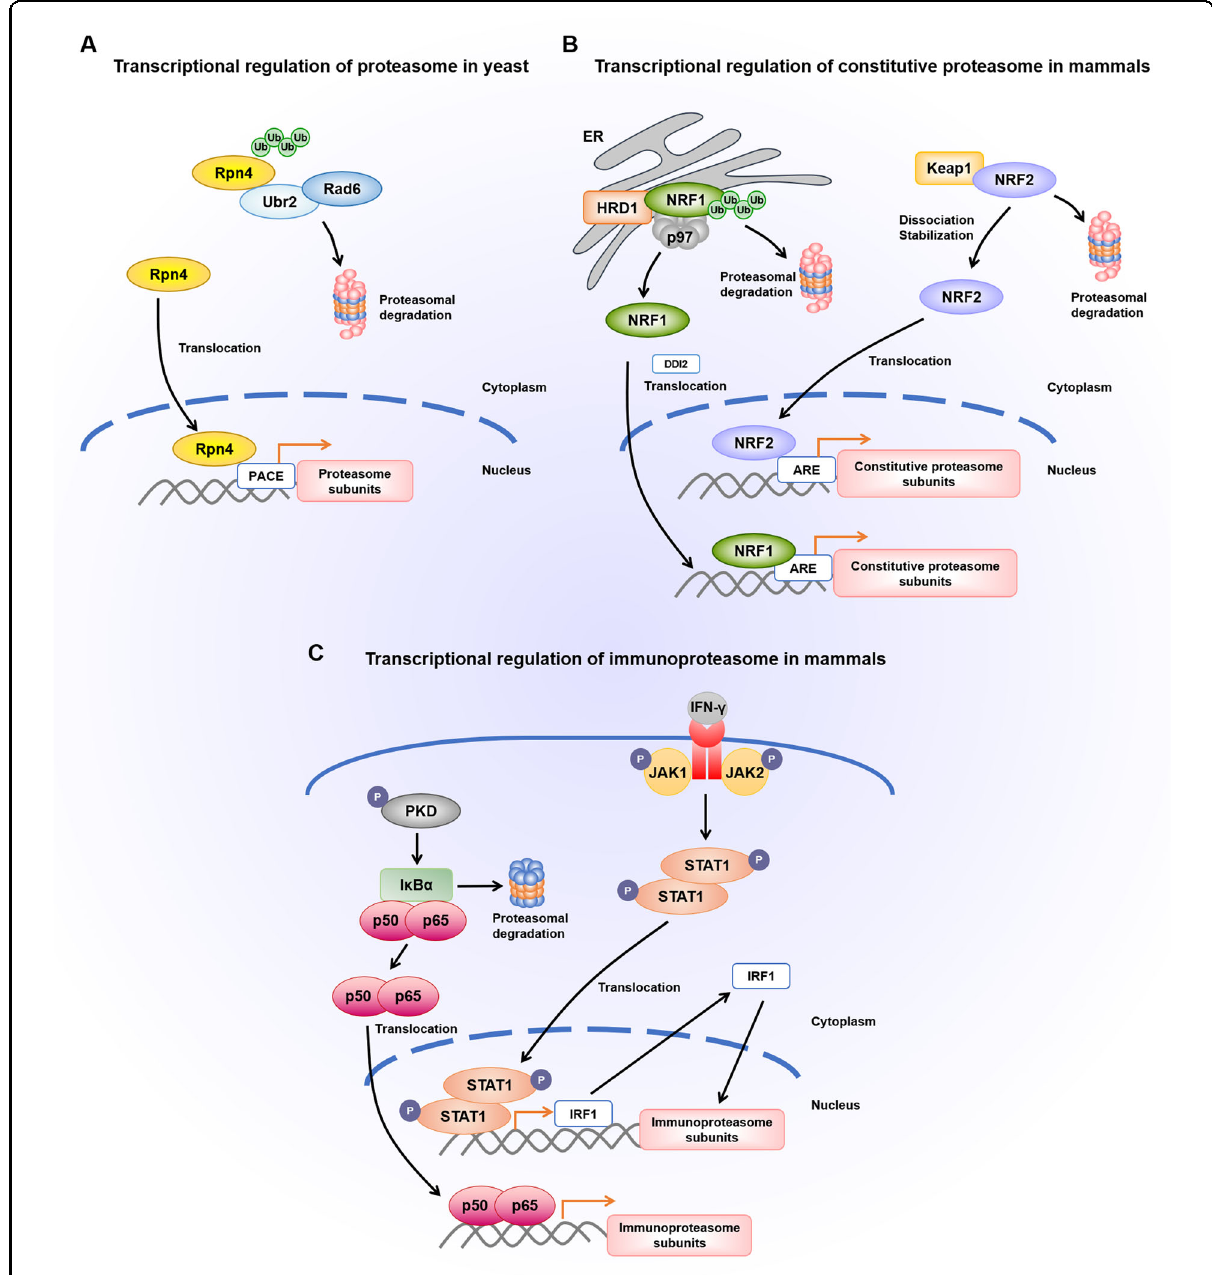
Fig. 2 Transcriptional regulation of proteasome expression. A Transcriptional regulation of proteasome in yeast. Rpn4 serves as a transcription factor with short half-life (t1/2 ~2min) owing to the proteasomal degradation mediated by E2 ubiquitin conjugating enzyme Rad6 and E3 ubiquitin ligase Ubr2. Upon proteasome inhibition, Rpn4 is translocated into the nucleus, where it binds to PACE sequence in the promoters of proteasome subunit genes, resulting in the compensatory increase of proteasome expression. B Transcriptional regulation of constitutive proteasome in mammals. NRF1 resides in the ER, which is degraded via ERAD pathway requiring ER-resident ubiquitin ligase HRD1 and ATPase p97. When the proteasome is inhibited, NRF1 is cleaved by DDI2, and then translocated to the nucleus where it binds ARE and activates the transcription of proteasome genes. During oxidative stress, NRF2-Keap1 complex disassociates, and NRF2 translocates into the nucleus to transcriptionally regulate proteasome expression. C Transcriptional regulation of immunoproteasome in mammals. Under the stimulation of IFN- γ , activated JAK1 and JAK2 leads to the dimerization and phosphorylation of STAT1, which translocates into the nucleus and binds to IRF1. Following translation, IRF1 moves back into the nucleus to increase the transcription of immunoproteasome. Upon oxidative injury, phosphorylated protein kinase D (PKD) leads to the disassociation of I κ B α from NF- κ B. In turn, I κ B α is degraded and NF- κ B translocates into the nucleus to regulate the expression of immunoproteasome.